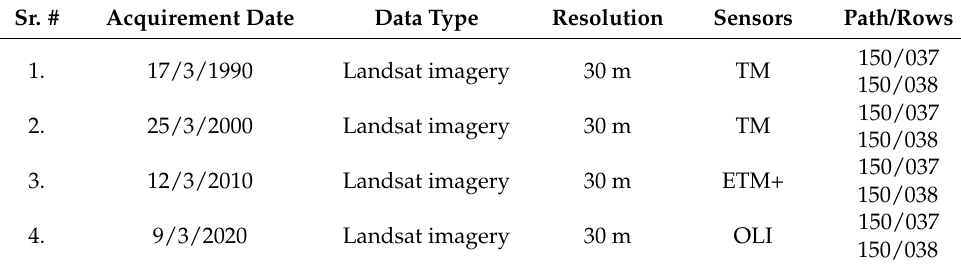
Table 1. Arrangement of Landsat satellite